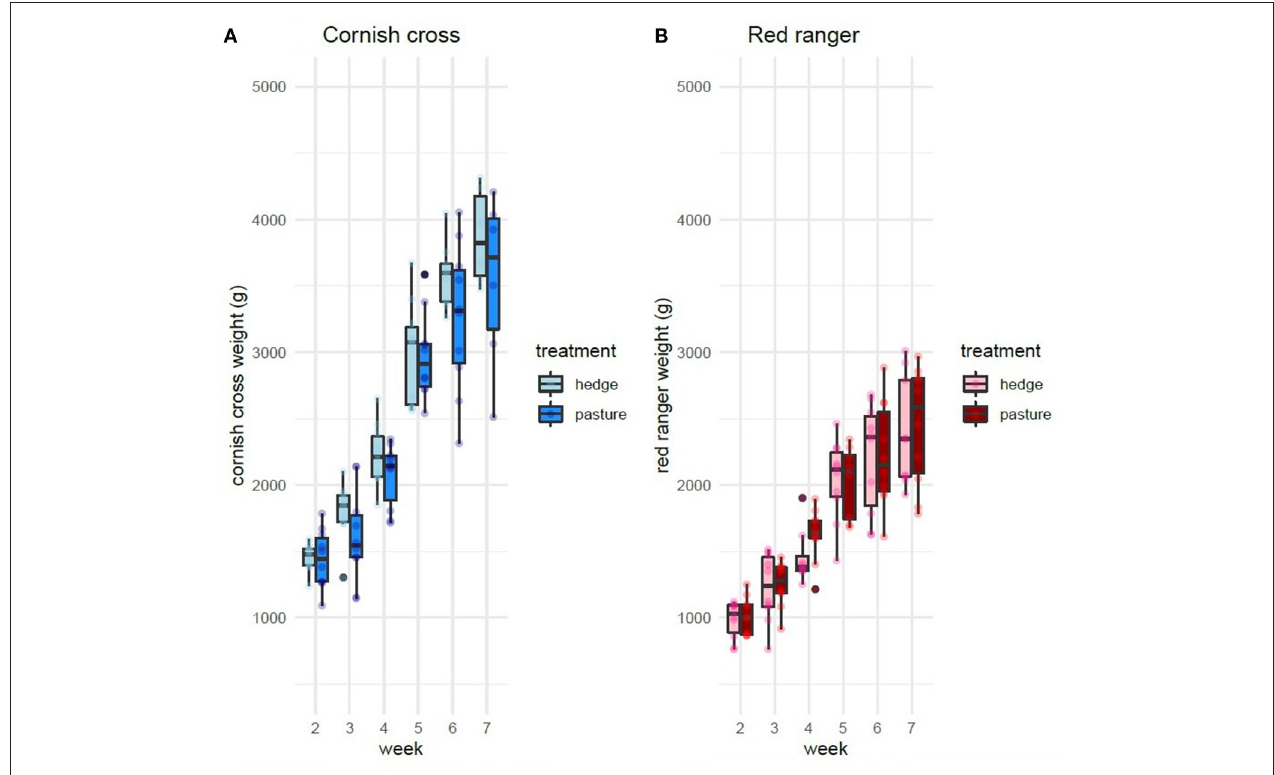
FIGURE 2 | Effect of treatment (hedge access) on weight gain of both breeds (A,B) . Cornish cross with access to the hedge gain weight faster than Cornish cross in bare pasture (A) . Hedge access had no significant effect on Red ranger weight gain (B) . LMEM Weight ∼ treatment + week + treatment * week + sex + per bird intake + start weight + (1|Block: